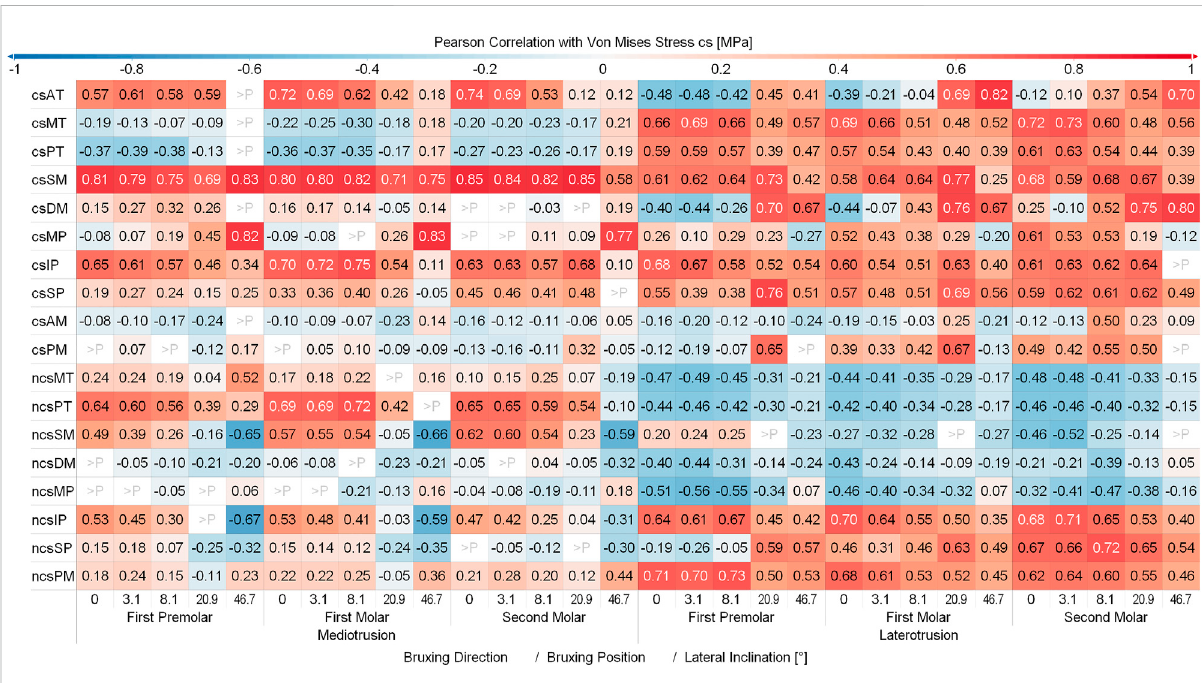
FIGURE 6 Correlation between muscles and contact side disc von Mises stress. Y-axis shows muscles with a mean activation > 20%; contact side (cs) and non-contact side (ncs); AT, anterior part of temporalis; MT, medial part of temporalis; PT, posterior part of temporalis; SM, super fi cial head of the masseter; DM, deep head of the masseter; MP, medial pterygoid; IP, inferior head of lateral pterygoid; SP, superior head of lateral pterygoid; AM, anterior mylohyoid; PM, posterior